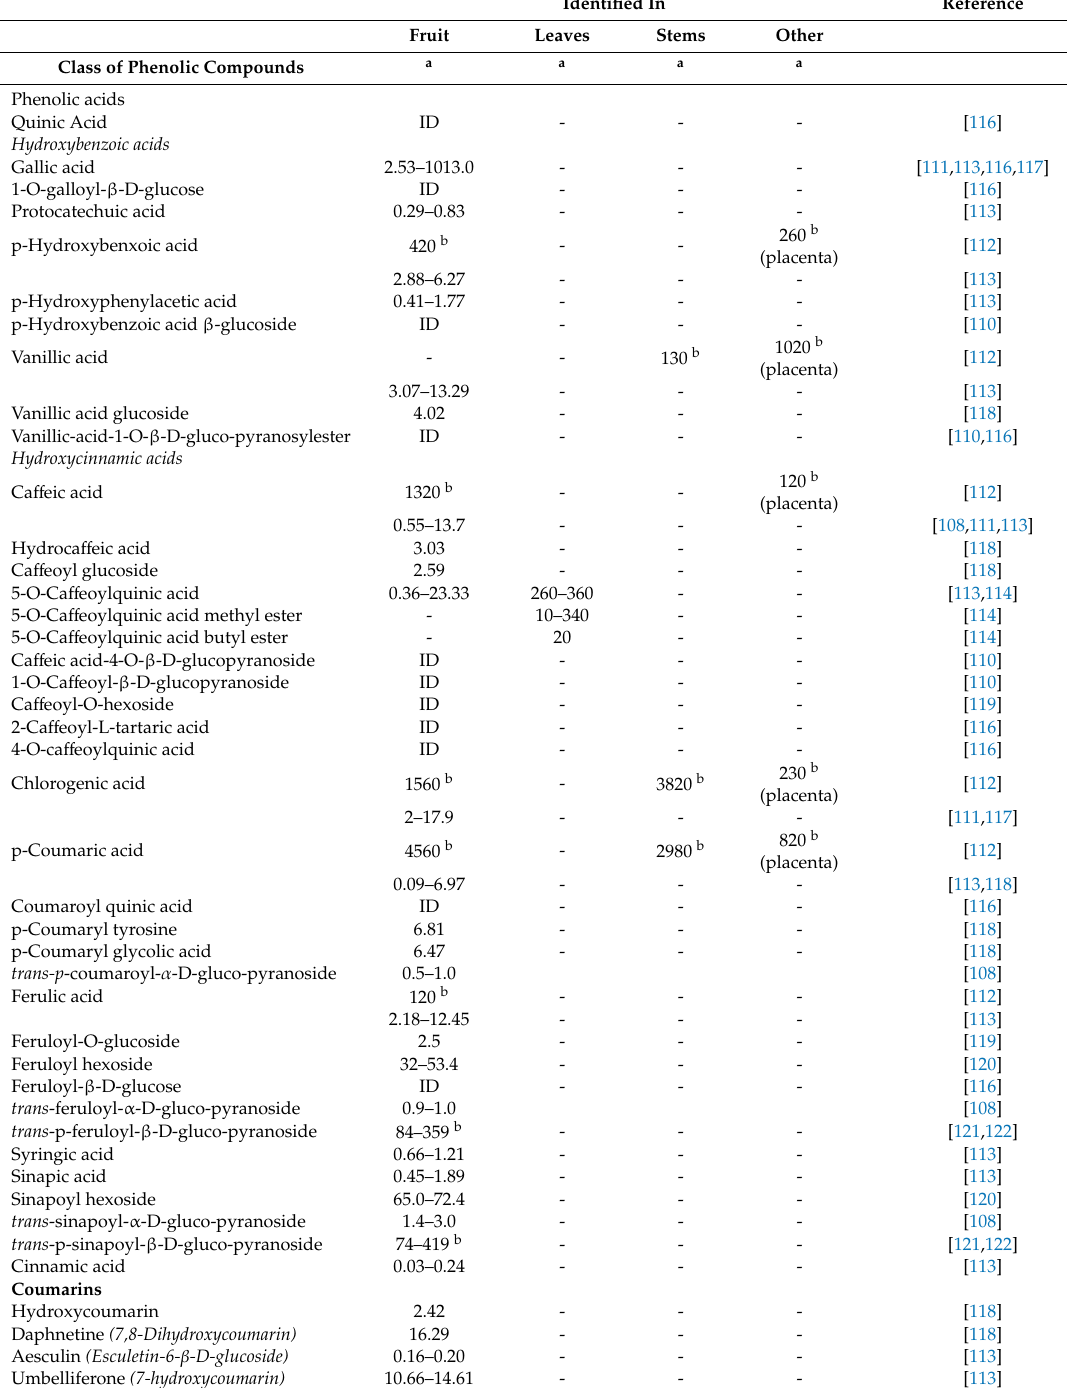
Table 2. Quantification of phenolic compounds from Capsicum annuum L. (a—content expressed in mg / kg fw; b—content expressed in mg / kg dw; fresh weight (fw); dry weight (dw) ID—Identified but not